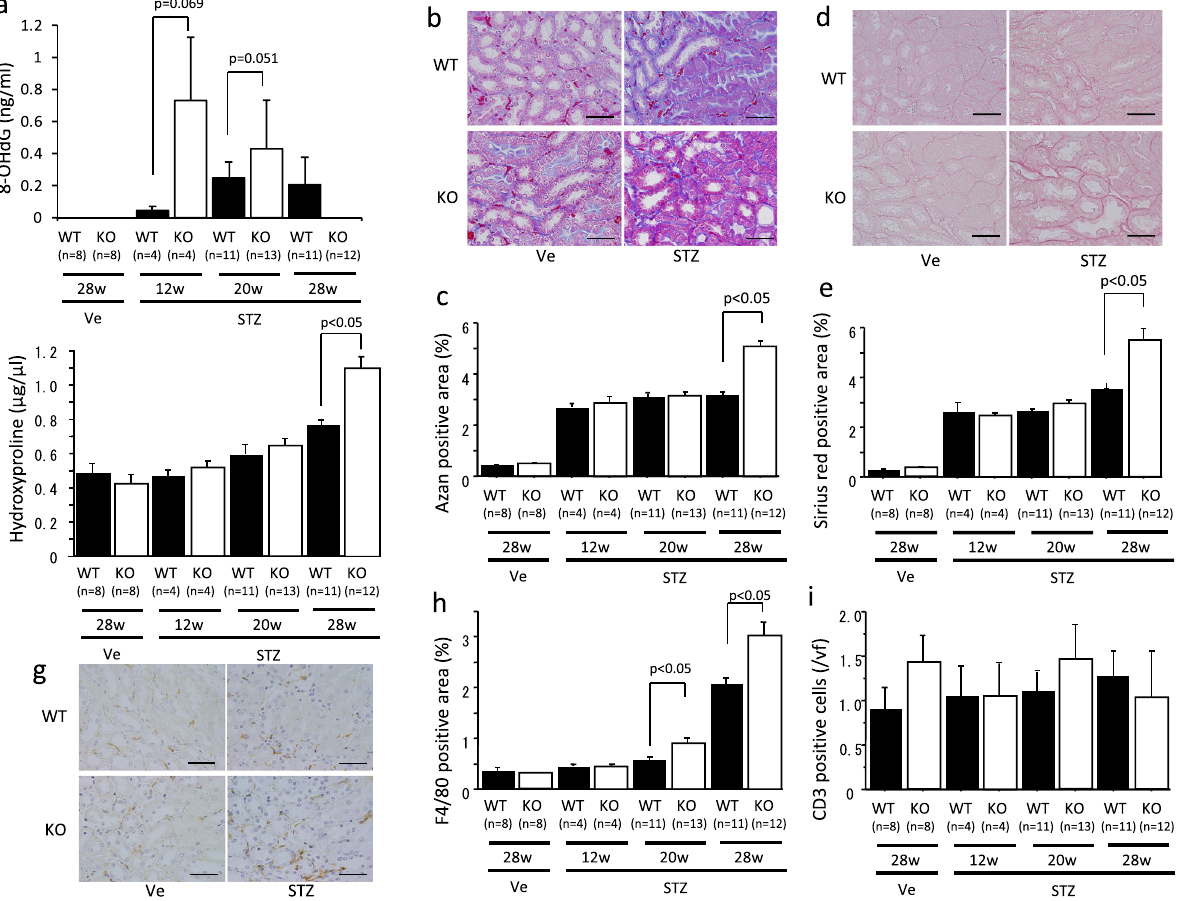
Figure 2. Evaluation of oxidative stress and interstitial fibrosis in STZ-induced diabetic mice. Urinary 8-OHdG levels were detected in the diabetic mice ( a ). Interstitial fibrosis was detected by Azan staining ( b ) and Sirus red staining ( d ), and the fibrotic areas were quantified ( c , e ). The amount of hydroxyproline in the mice kidneys was measured ( f ). Interstitial F4/80-positive cells were detected by immunohistochemistry ( g ) and their positive area was evaluated ( h ). The number of CD3-positive cells was also detected by immunohistochemistry and counted ( i ). KO, octn1 KO mice; WT, wild type mice; STZ, STZ injected mice; Ve; vehicle control. The scale bar represents 100